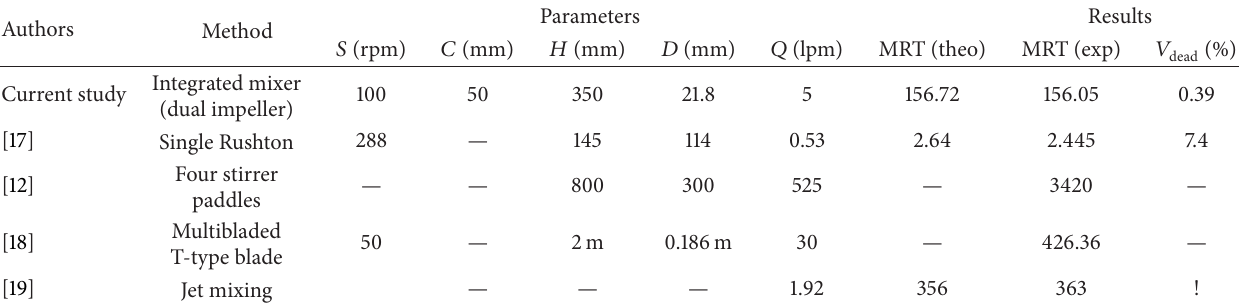
Table 7: Comparisons of current technique using Taguchi method and other method.